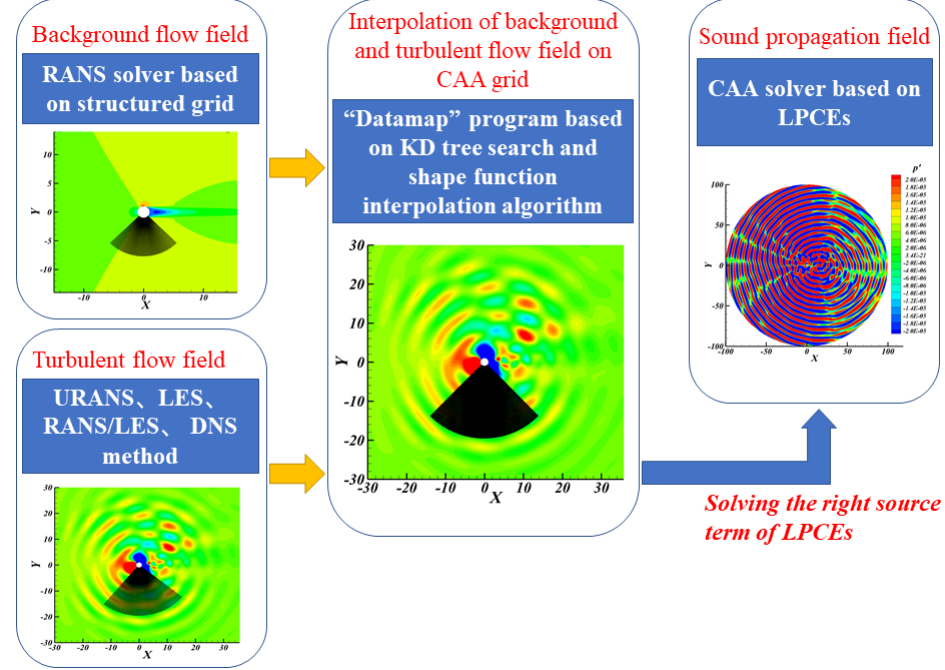
Figure 2. The framework of the CFD/CAA hybrid method.